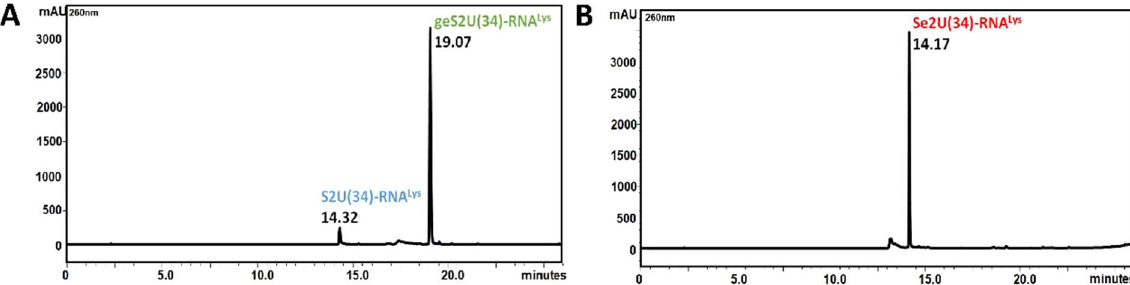
Figure 2. HPLC chromatograms showing the typical course of the reactions: ( A ) geranylation and ( B ) selenation of the ASL–RNA Lys models. The reaction efficiencies, estimated based on a comparison of the areas under the substrate and product peaks, were 91% and 100%, respectively.